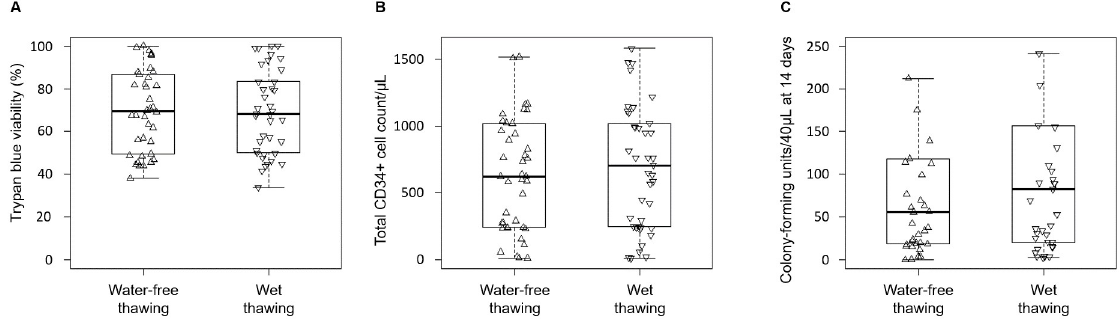
Fig 1. The comparative effect of water-free and wet thawing on the post-thaw outcome of haematopoietic cells from cryopreserved leukapheresis samples. (A) Cell viability immediately post-thaw determined as trypan blue exclusion (B) Total CD34+ cell counts (through flow analysis). (C) Colony forming units counted after 14 days post-thaw incubation. The p -values obtained from comparing means between thawing methods are indicated.